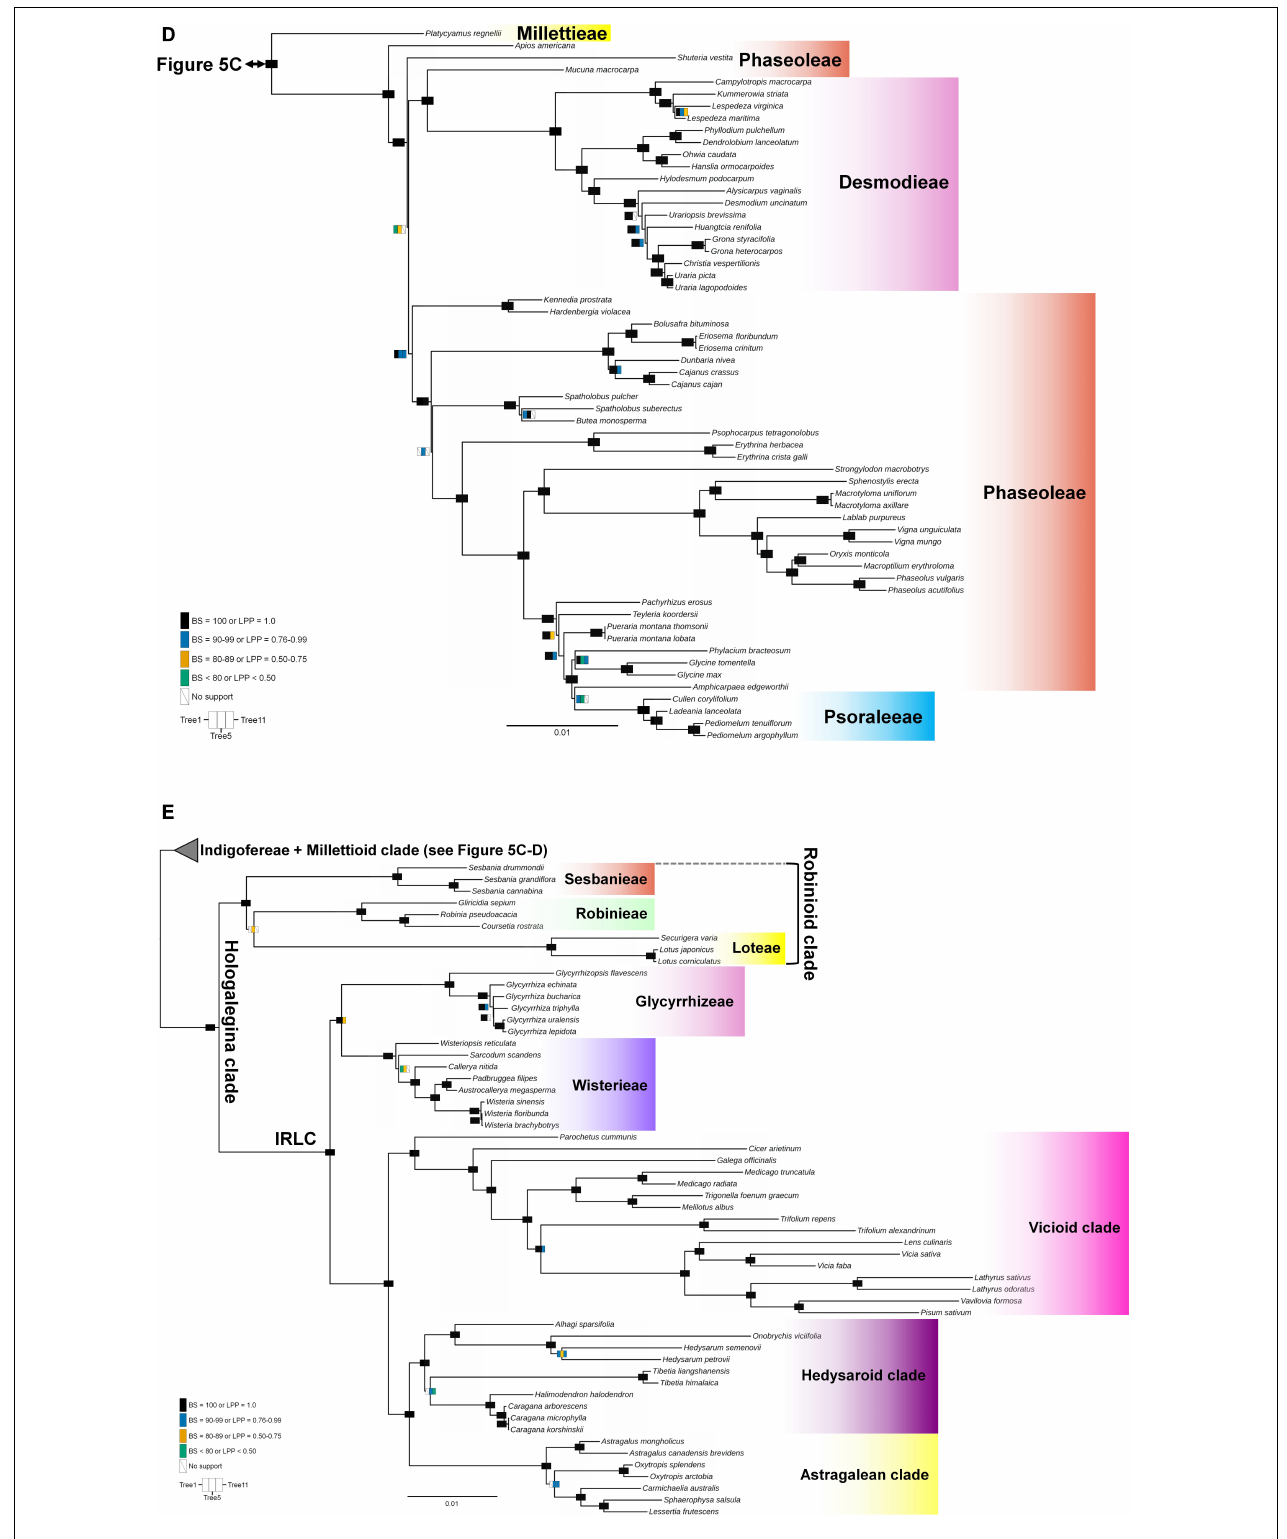
FIGURE 5 | A maximum-likelihood tree based on a concatenated dataset of 77 plastome coding regions with Gblocks trimming (See Table 1 ). The figure is separated into five panels with a focus on the major clades. (A) Swartzieae, ADA (Angylocalyceae, Dipterygeae, and Amburaneae), Cladrastis, Andira,